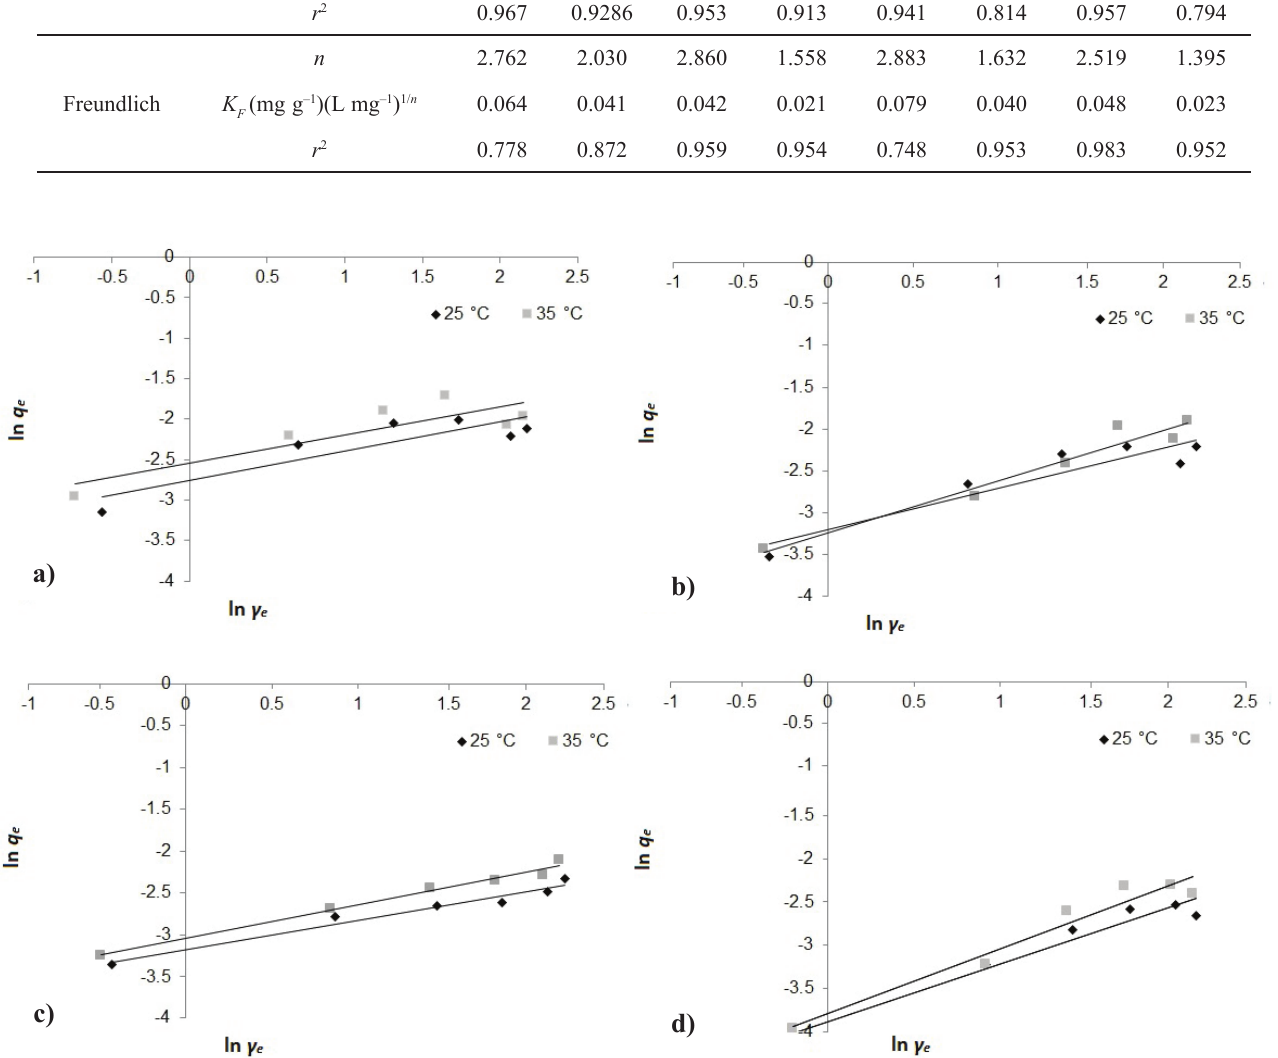
= 1 g L –1 , T = 25 °C and 35 °C, ads